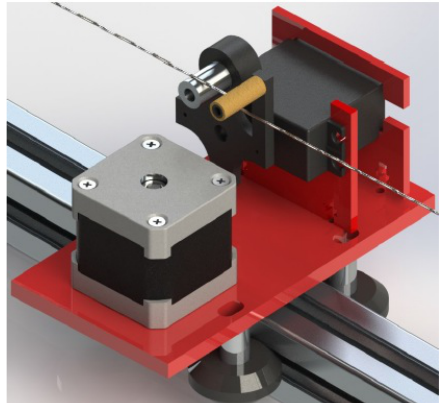
Fig. 11. Group II’s string clamping and vibration minimising